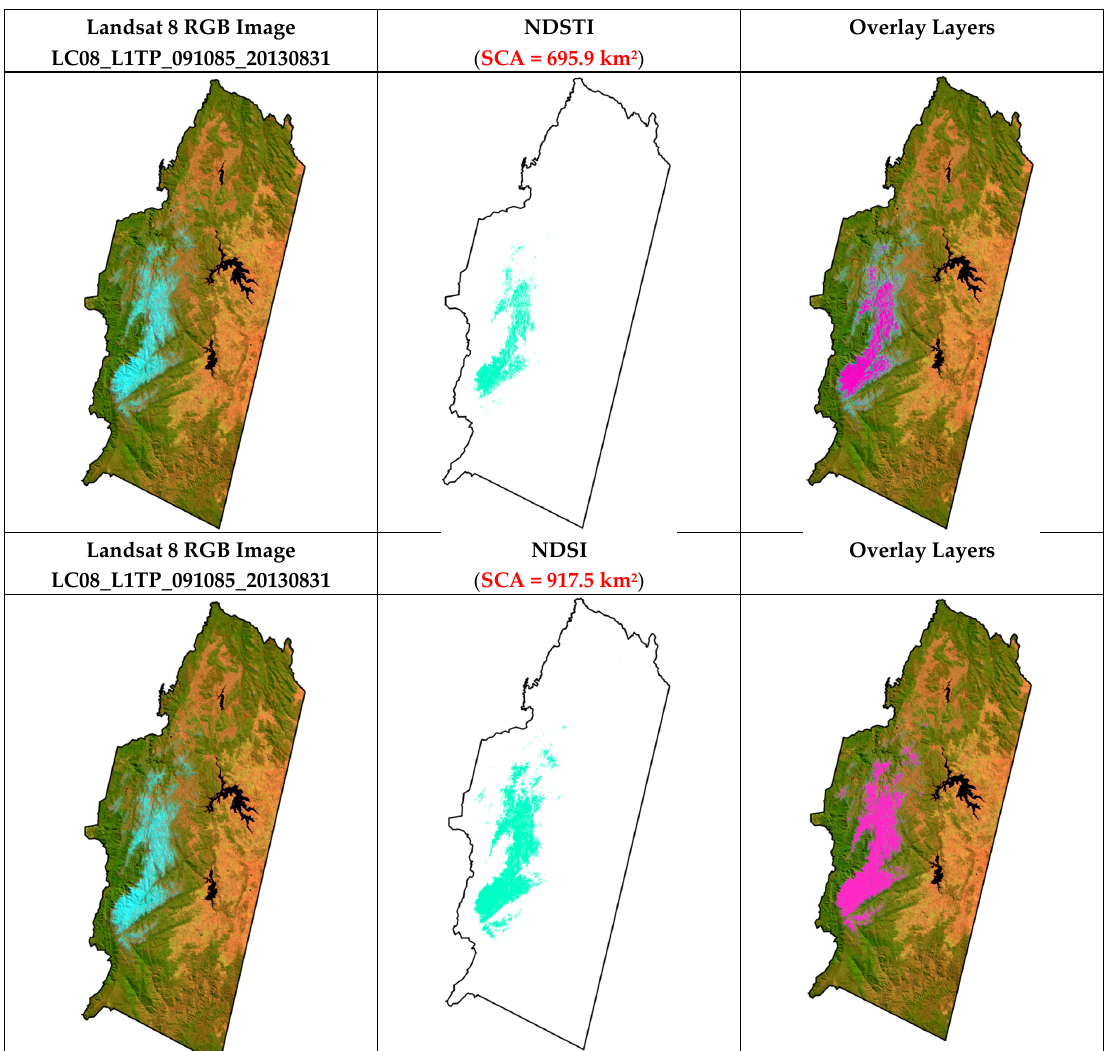
Figure A4. The original Landsat 8 RGB image ( left column), respective extracted snow maps by the NDSTI and NDSI ( middle column), and the overlay layers ( right column) for two times on the 31 August 2013.